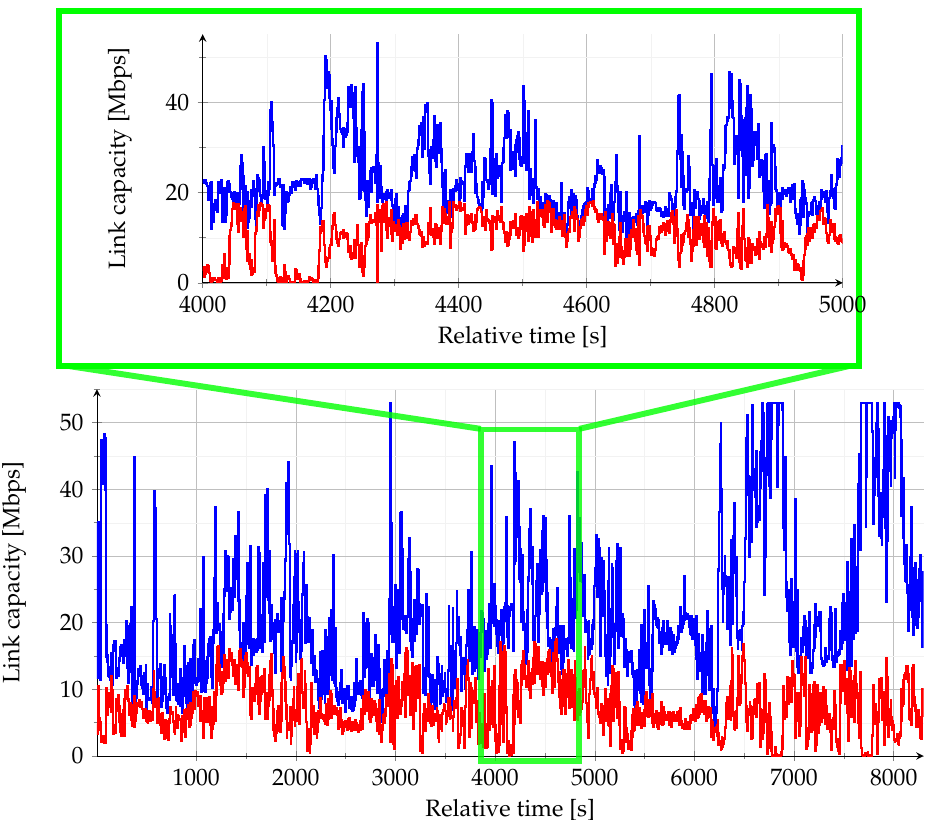
Figure 1. Evolution of the available downlink channel capacities of the primary and secondary cells over time: averaged to 1s ( top ) and 5s ( bottom ) time